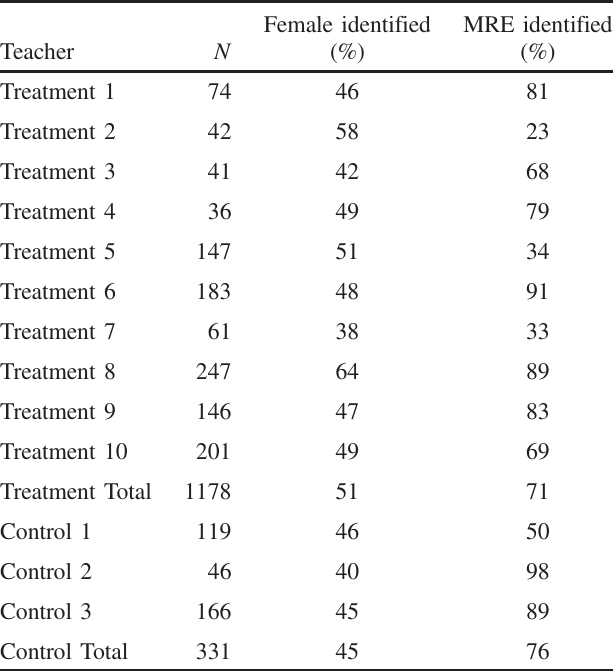
TABLE X. Summary of Study 2 sample, by teacher. Percent- ages quoted are the combined results after imputation ( m ¼ 100 ).